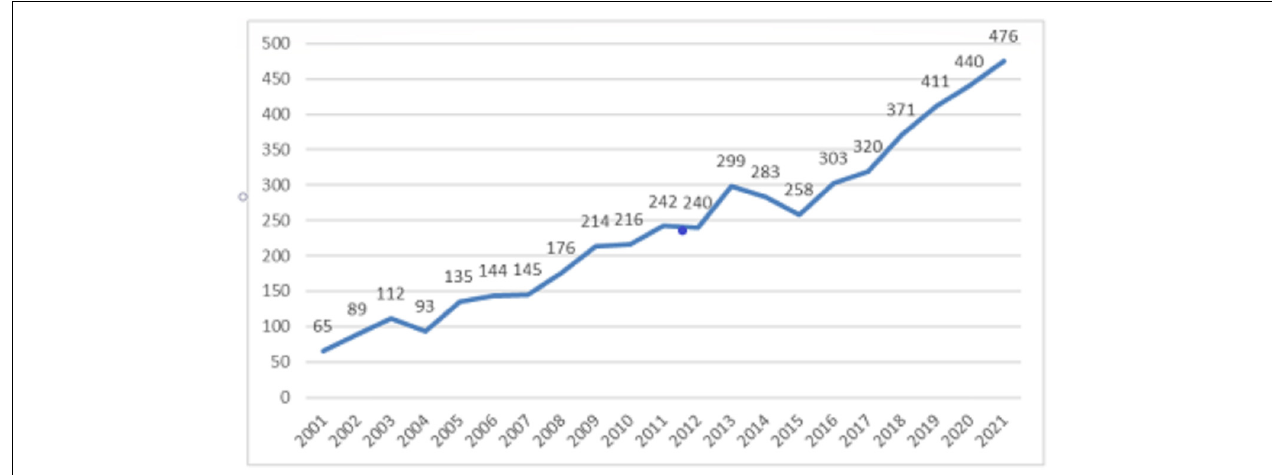
FIGURE 1 | Annual quantitative distribution of the psycho-cardiological disease.